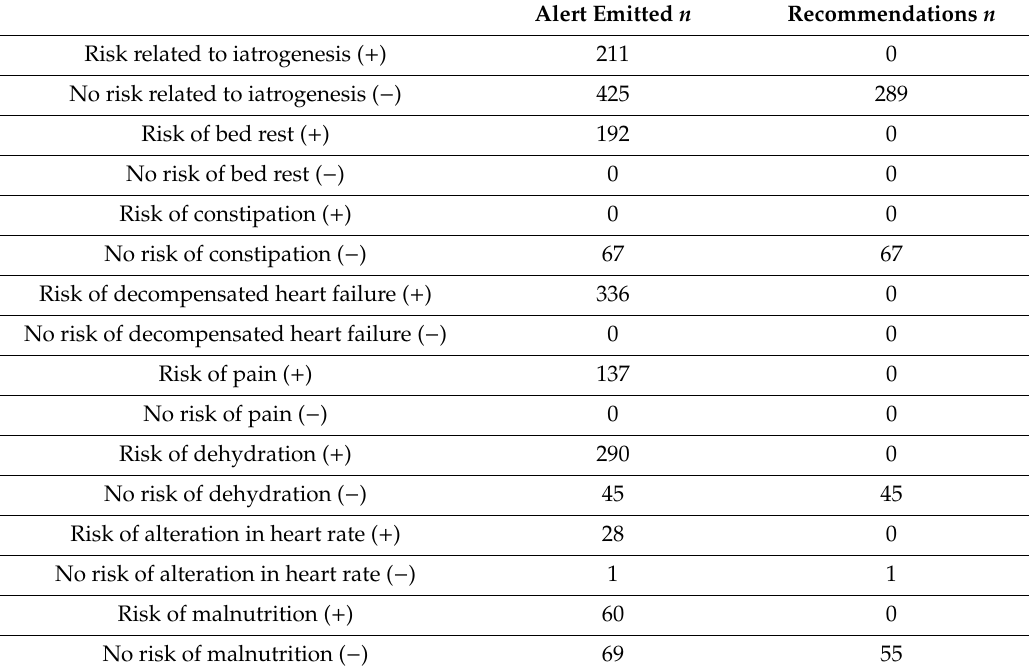
Table 8. Alerts and recommendations issued for the geriatric risks